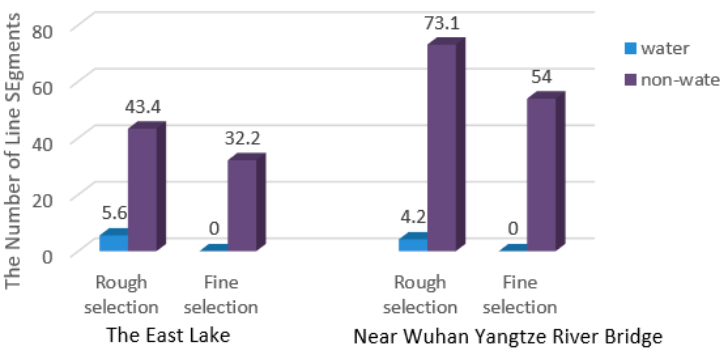
Figure 8. Average number of line segments on the East Lake and near Wuhan Yangtze River Bridge; the blue and purple respectively correspond to the water and non-water area.